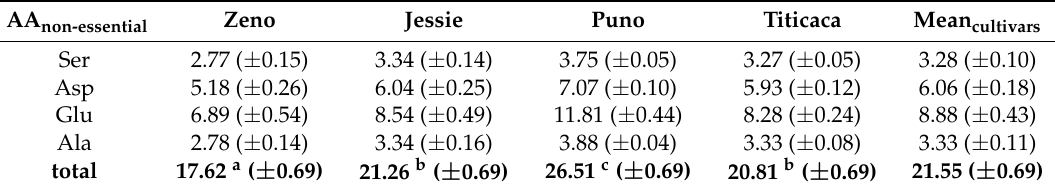
Table 7. Two-year mean values of non-essential amino acid (AA) composition (in g 100 g − 1 crude protein, ± SE 1 ) for the four quinoa cultivars (Zeno, Jessie, Puno, Titicaca). Total amount means in one row followed by the same letter are not significantly different from each other ( p < 0.05).